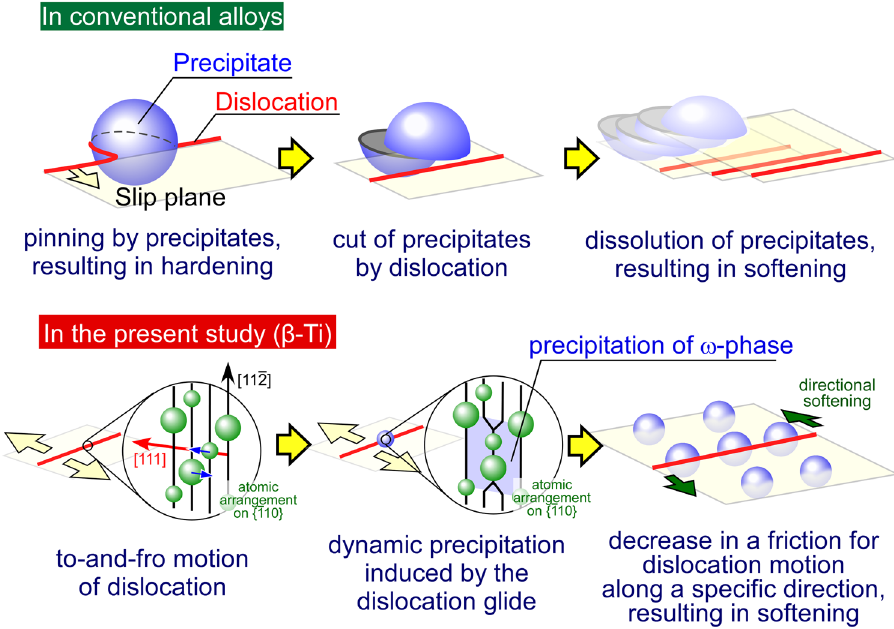
Figure 4. The difference in the softening mechanisms of the alloys induced by cyclic deformation, in conventional alloys and in the β -Ti alloys which was first found in the present study. On the detailed mechanism of the dynamic precipitation of ω -phase by dislocation glide, further explanation is available in Fig. 6.